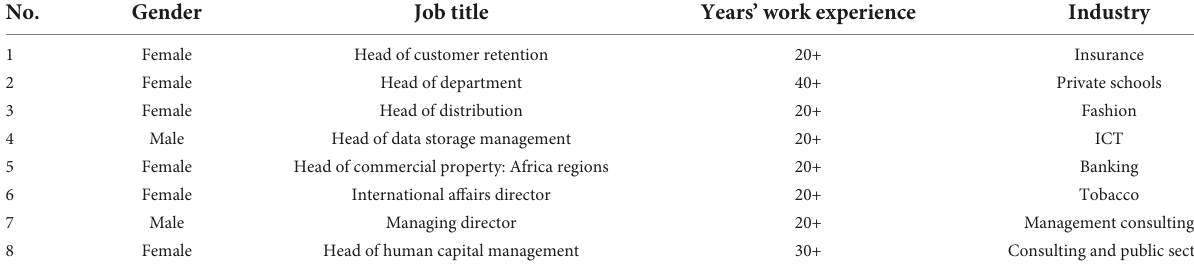
TABLE 1 Biographical information of